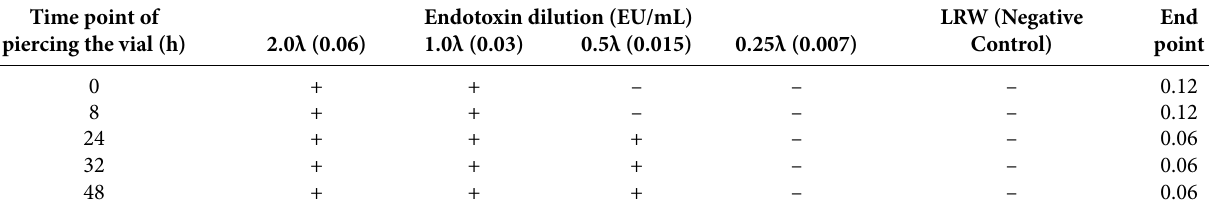
Table 3. Bacterial endotoxin testing after multiple piercing of the same vial Time point of Endotoxin dilution (EU/mL) piercing the vial